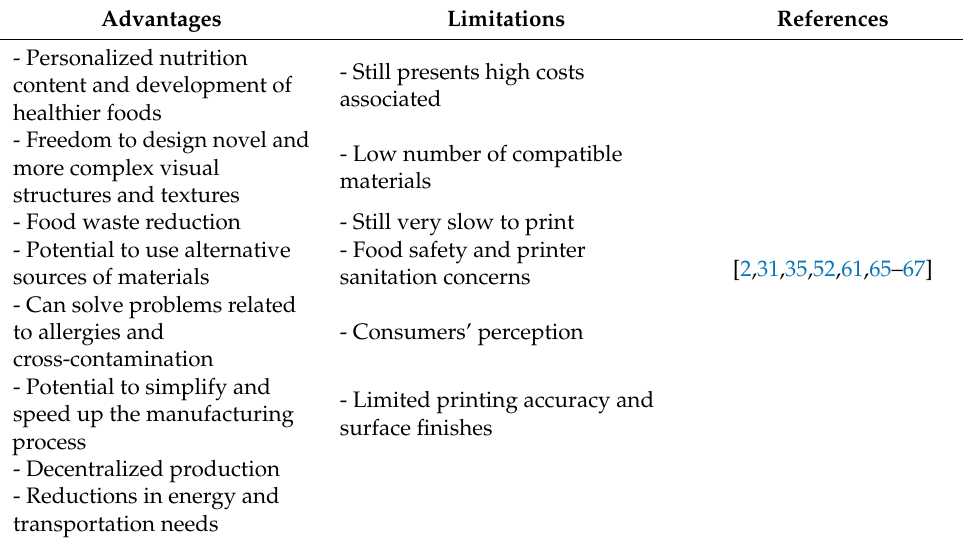
Table 1. Some advantages and limitations of using 3D Printing for food printing.